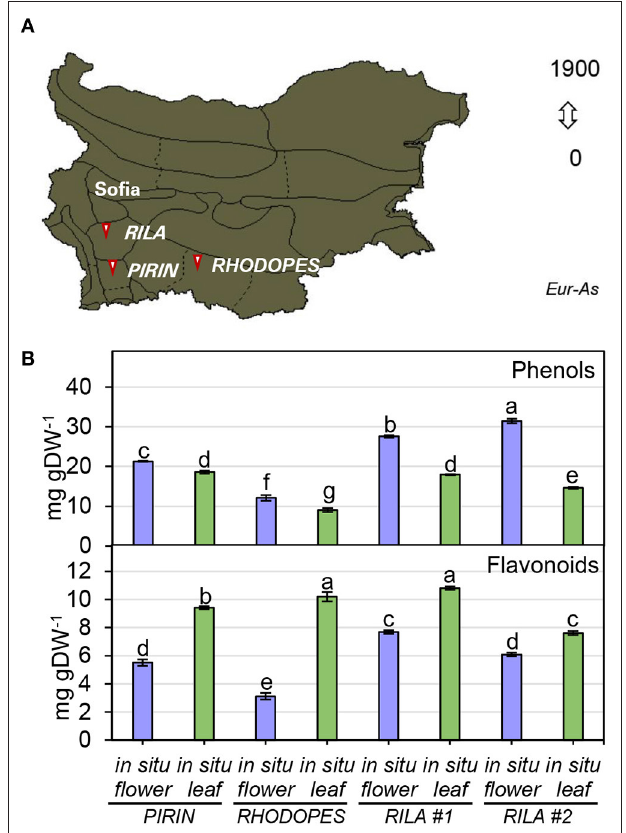
FIGURE 3 | Total phenolics in flowers and leaves of N. nuda in situ plants from different habitats. (A) Distribution map of N. nuda in Bulgaria shown in dark color according to Assyov et al. (2012). Arrows indicate the habitats of the studied in situ plants in Pirin, Rhodopes and Rila # 1 and Rila # 2. Samples of vouchers are deposited in the Herbarium of Sofia University “St. Kliment Ohridski,” Sofia, Bulgaria. (B) Total content of phenolics in flowers and leaves from in situ populations: total phenolic content; total flavonoid content. Mean values ± SE (15 plants; n ≥ 3 technical repeats). One–way ANOVA